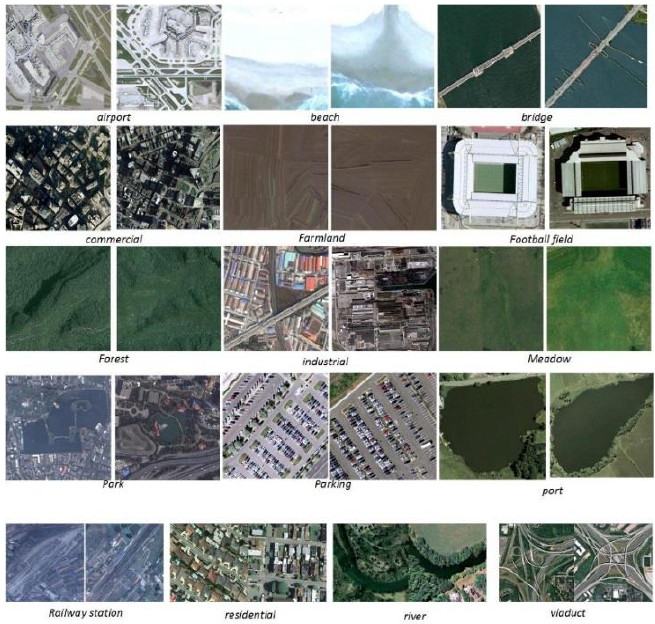
Figure 9. Two Example images of categories misclassified with KCRC method but classified accurately with two-step classification method in WHU-RS dataset.